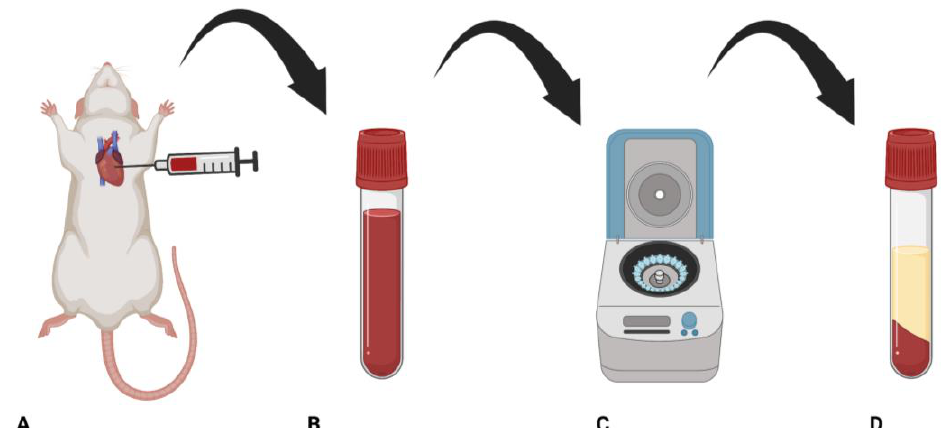
Figure 1. ( A ) Intracardiac puncture in the rat’s heart using a syringe with a needle ranging between 18 to 23G; ( B ) Blood placed in tube (without additives); ( C ) The tube is then quickly placed in the centrifuge, following protocols for PRF production, rpm, time, and relative centrifugal force (RCF); RCF = relative centrifugal force; NR = not reported. ( D ) PRF is produced after following the previous steps.